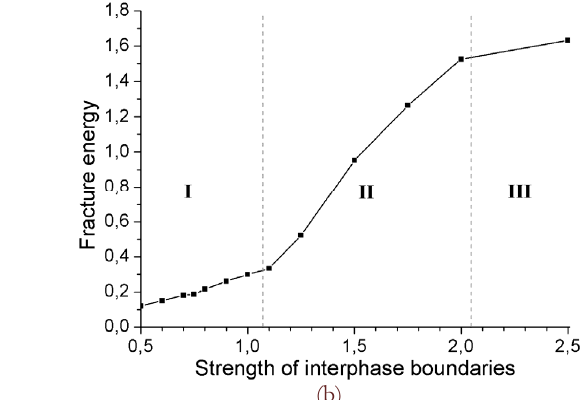
Figure 14: Strength (a) and fracture energy (b) in model metal-ceramic composite depending on interphase boundary strength bound Values of interphase boundary strength and “macroscopical” composite strength are normalized by tensile strength of the binder NiCr  . Fracture energy was calculated as an area under the loading diagram expressed in the units “normalized stress – bending angle” t (Fig.